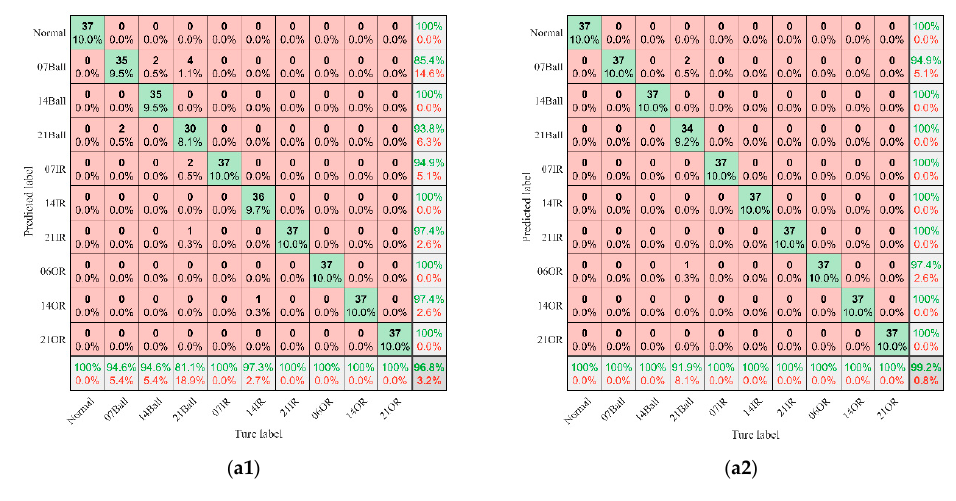
Table 5. F-Score results obtained with CNN and